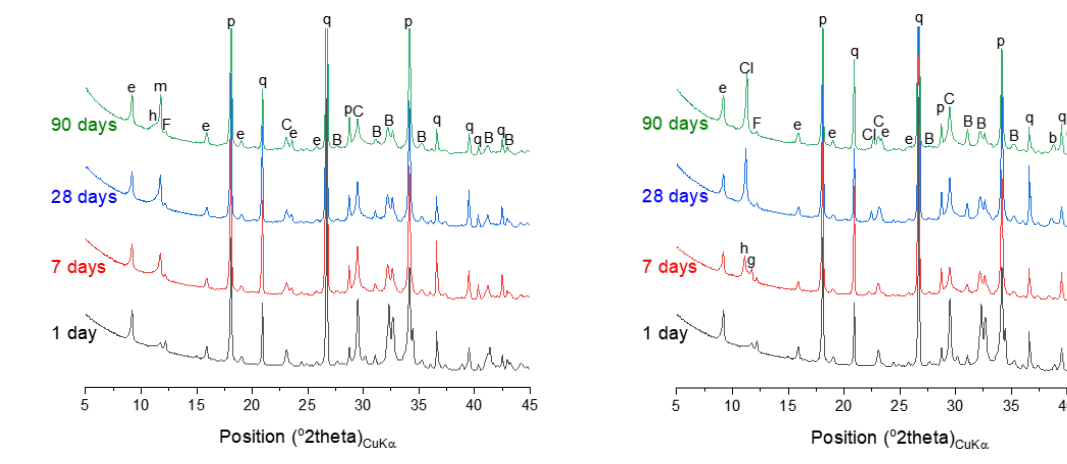
Figure 7. Predicted phase assemblages of neat PC and PC blended with silica fume, metakaolin or glass powder during hydration and after immersion in seawater.